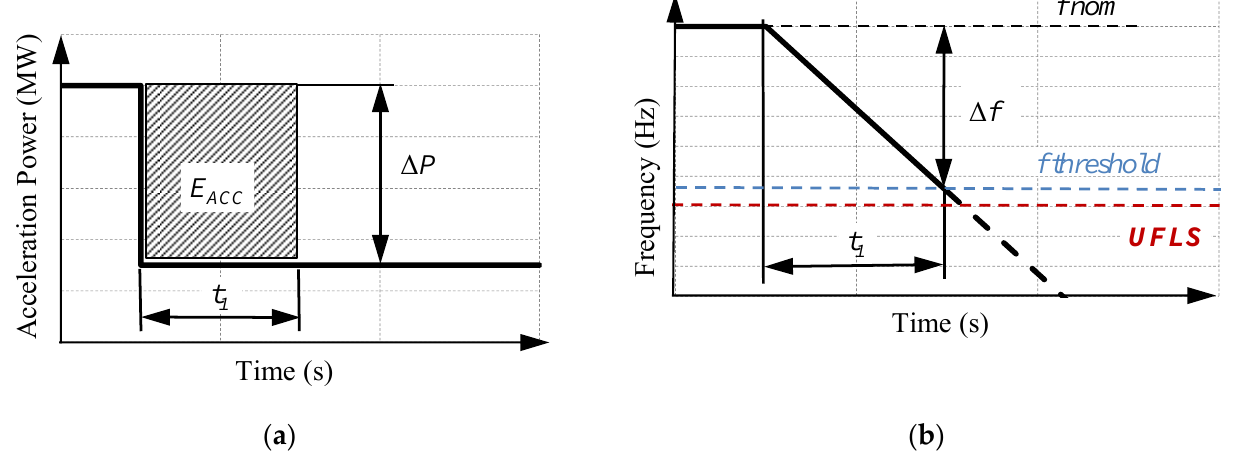
Figure 1. ( a ) Fixed acceleration power; ( b ) linear frequency